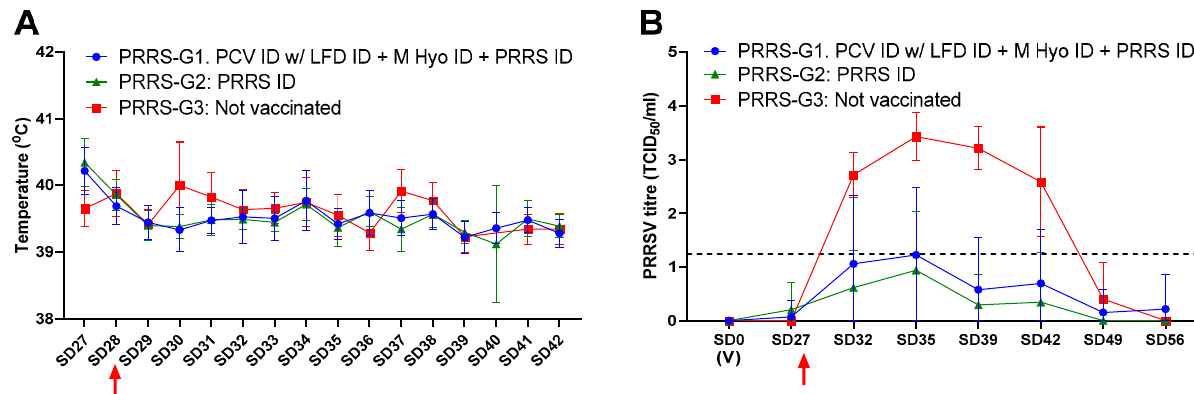
Figure 2. PRRSV challenge study results. ( A )—mean rectal temperatures during the challenge period; ( B )—PRRSV viraemia (mean virus titre in serum titrated on PAM cells, dotted line indicates assay cut-off). (V) Indicates time of vaccination. Arrow indicates challenge. Error bars show standard deviation. Table 1. Seropositivity to PRRSV pre ‐ vaccination (SD0), pre ‐ challenge (SD27) and end of study (SD56), and average daily weight gain post ‐ challenge (SD27 – SD56) .